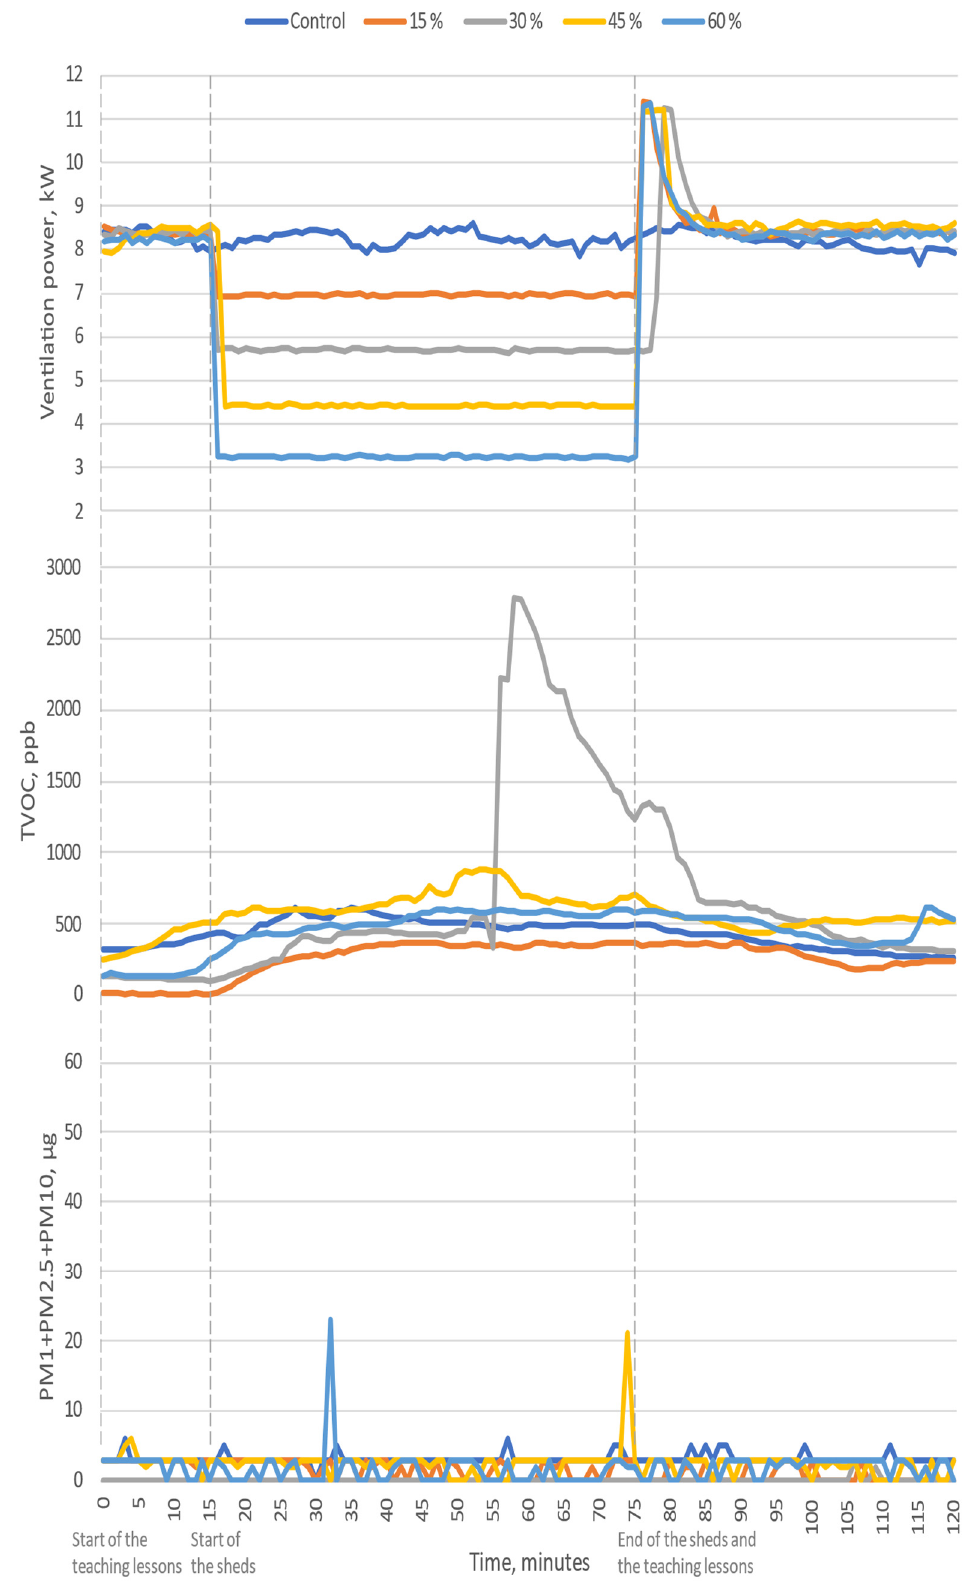
Figure 6. The ventilation power and the indoor TVOC and the particle sensor data obtained from the 60 min tests.